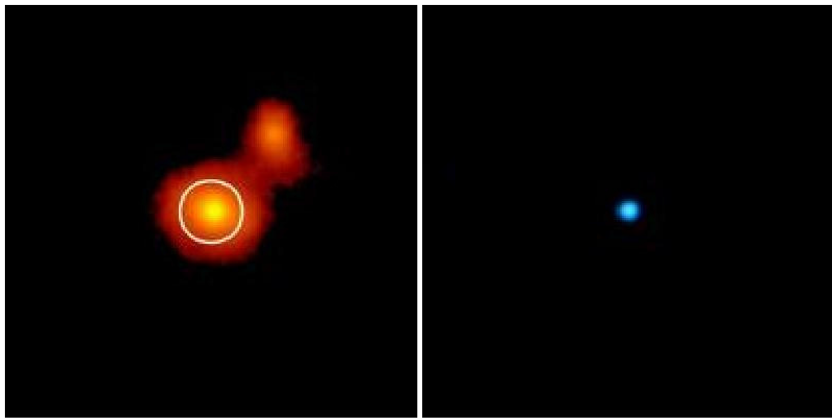
Fig. 3 Optical and X-ray images of RX J1242-11. Credits: (left) ESO/MPE/S.Komossa and (right) NASA/CXC/MPE (Komossa et al. 2004)